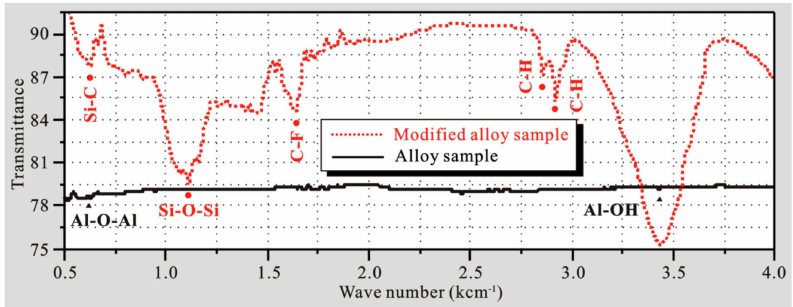
Figure 8. FTIR spectra on 7075 alloy surfaces before and after